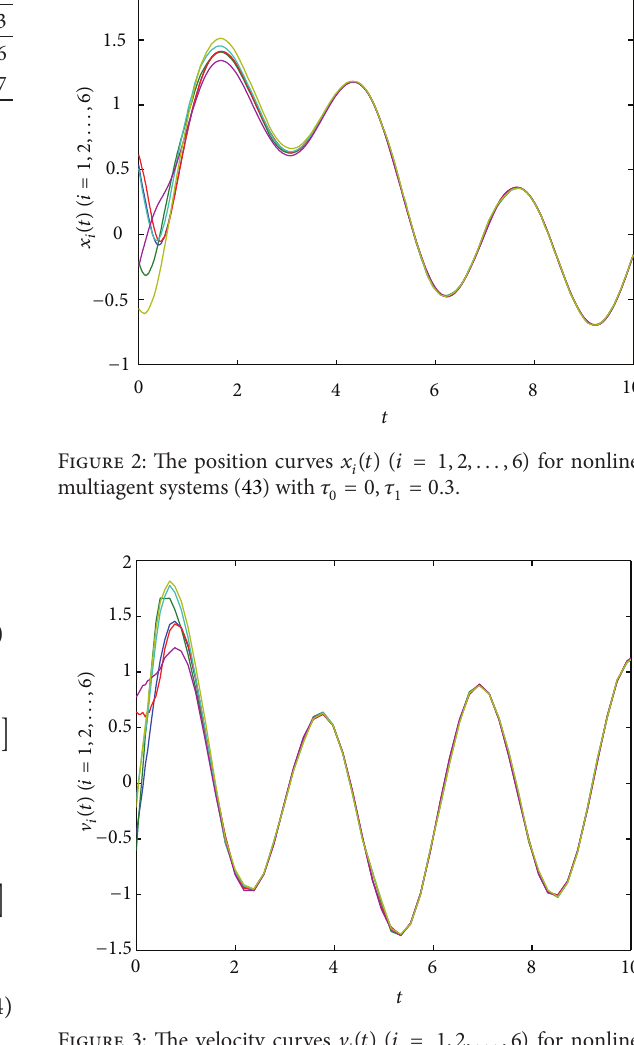
Table 1: The allowable upper bound of time delay for different 𝑀 .